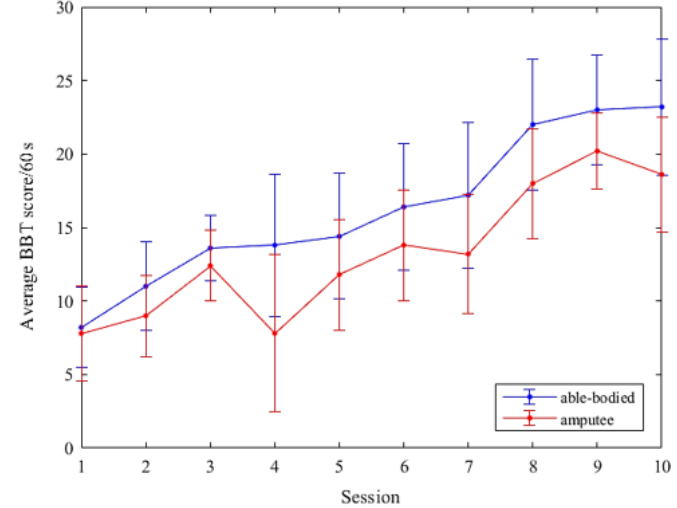
Figure 4. Mean score in the box and block test per 60 seconds over 10 training